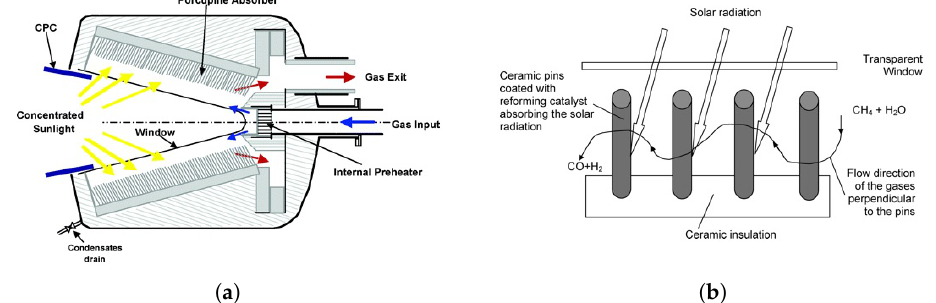
Figure 4. Reactor ( a ) and detail of the absorber ( b ) configuration proposed by the Weizmann Institute of Science. Reprinted with permission from [32]. Copyright (2006) American Chemical